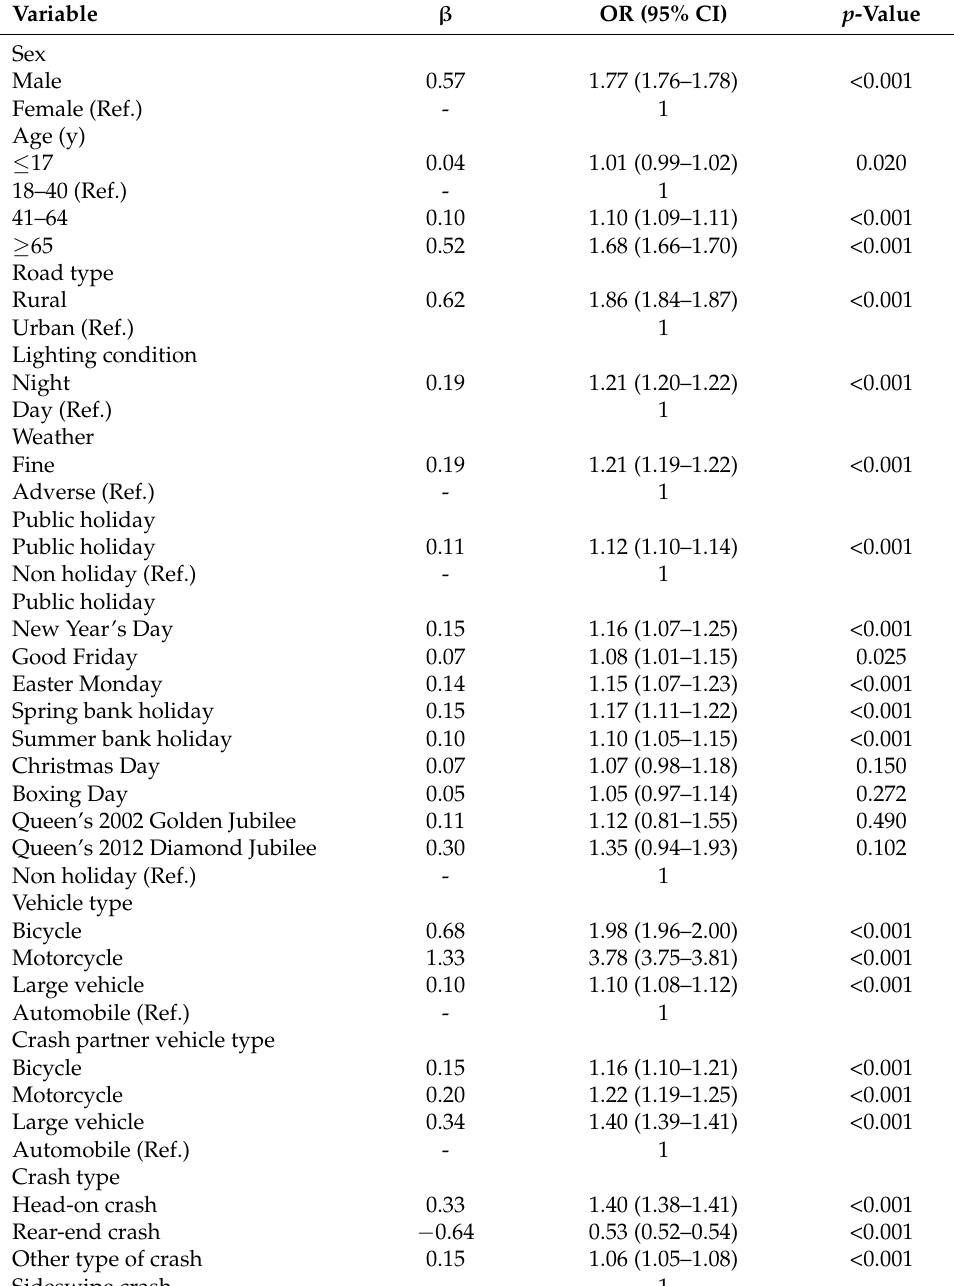
Table 3. Simple logistic regression results of factors associated with KSI casualties (data based on UK STATS19 1990–2017) [24].